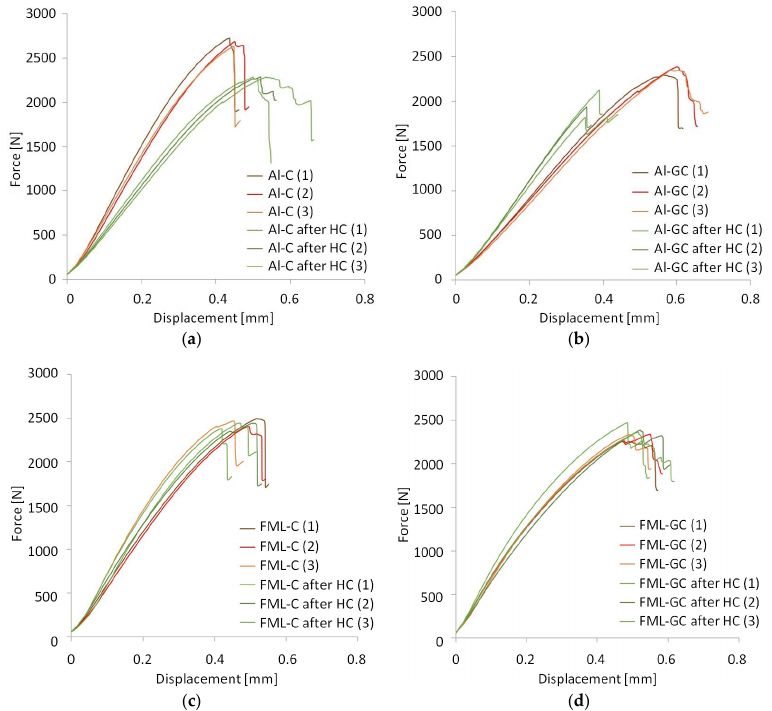
Figure 5. Force – displacement curves of fiber metal laminates (FMLs) after interlaminar shear Figure 5. Force–displacement curves of fiber metal laminates (FMLs) after interlaminar shear strength strength (ILSS) tests: ( a ) Al-C, ( b ) Al-GC, ( c ) FML-C, and ( d ) FML-GC. (ILSS) tests: ( a ) Al-C, ( b ) Al-GC, ( c ) FML-C, and ( d )